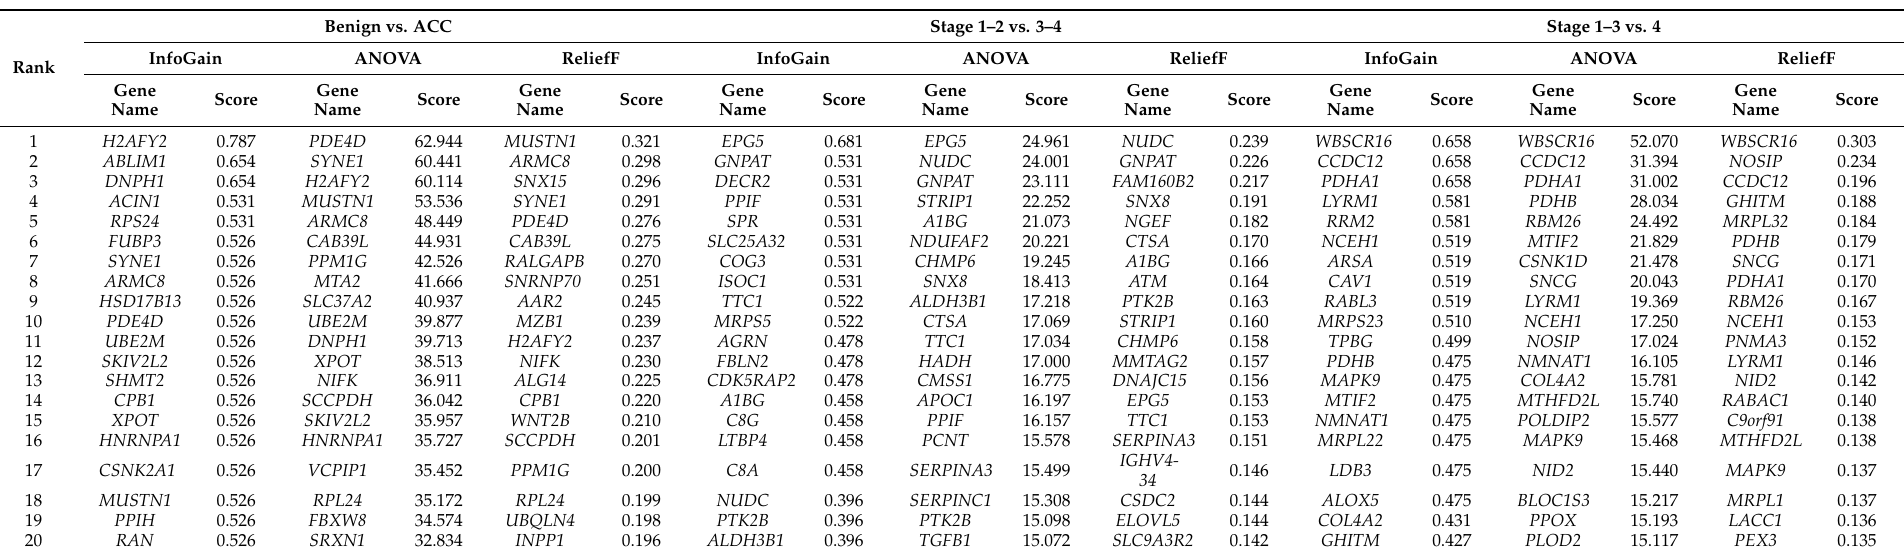
Table 2. Top 20 proteins of machine learning